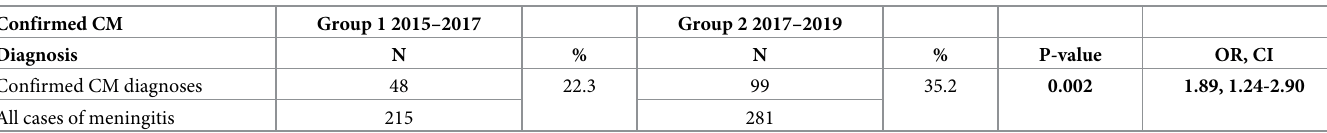
Table 4. Impact of the CM-DTP on diagnosis.